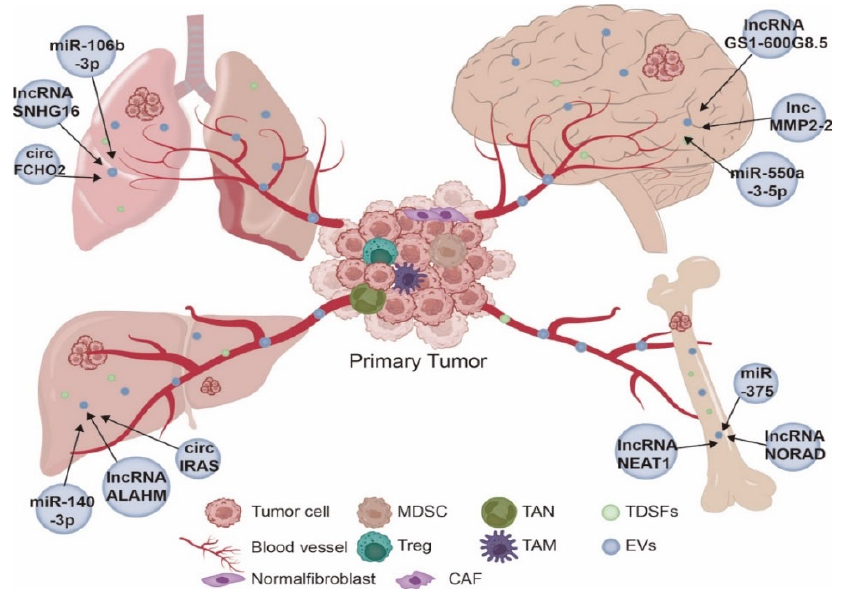
Figure 3. NcRNAs derived from EVs promote organ ‐ specific metastasis. Primary tumor cells secrete EVs into the circulation as messengers. These EVs educate recipient cells in specific target organs with bioactive cargos, followed by organotropic colonization of tumor cell.